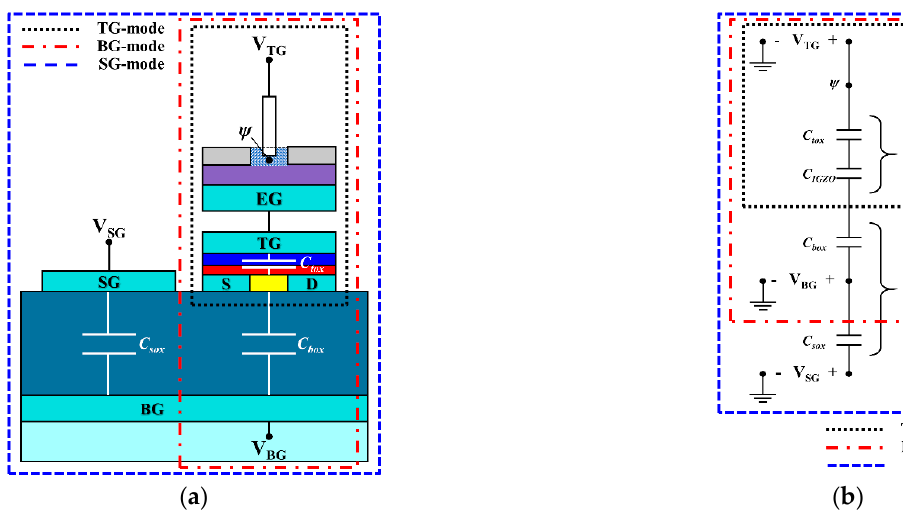
Figure 5. ( a ) Cross-sectional diagram and ( b ) equivalent circuit of a triple-gate a-IGZO TFT-based ISFET sensor platform.